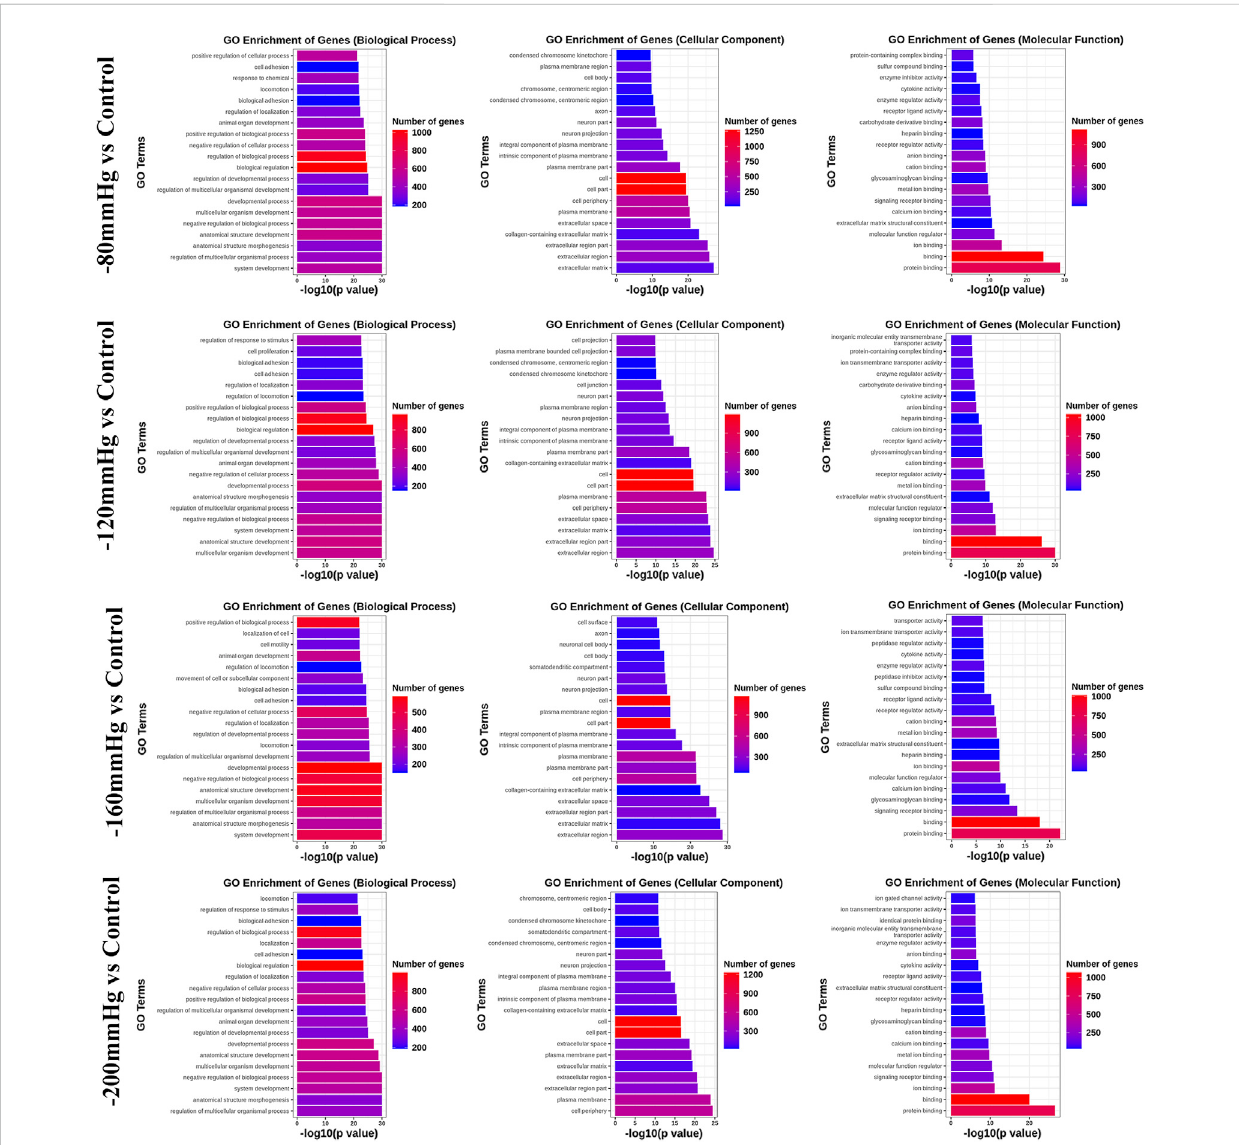
FIGURE 9 GO analysis of DEGs in − 80 mmHg vs. control, − 120 mmHg vs. control, − 160 mmHg vs. control, and − 200 mmHg vs.